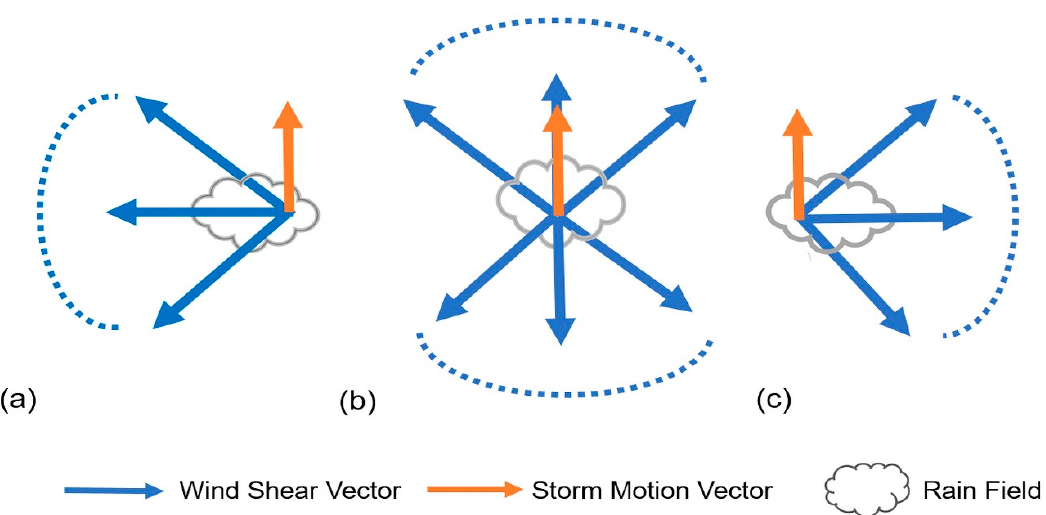
Figure 6. Diagram showing relationships between storm motion and vectors of the vertical wind shear (blue arc to indicate all angles between the arrows) and hypothesized position of the resulting rainfall regions for the ( a ) AL; ( b ) S; and ( c ) AR patterns.